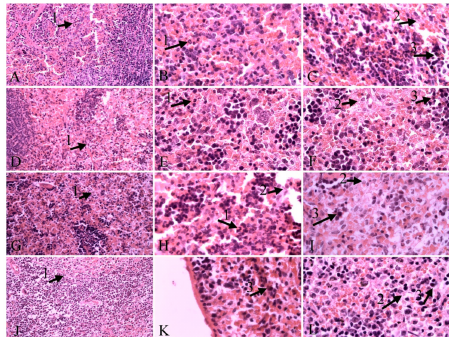
Figure 3. Spleen tissue. A , B , C : control group; D , E , F : carvacrol group; G , H , I : glucantime group; J , K , L : thymol group; (1), parasites in spleen cell (2), hemosiderin (3), H&E staining, 40 × , 100 × magnification. Table 3. Histological alteration of hamster spleens in the groups treated with carvacrol, thymol, and glucantime in comparison with the control group. Neutrophil Presence of Presence of the Necrosis Infiltration Hemosiderin Parasite Control +